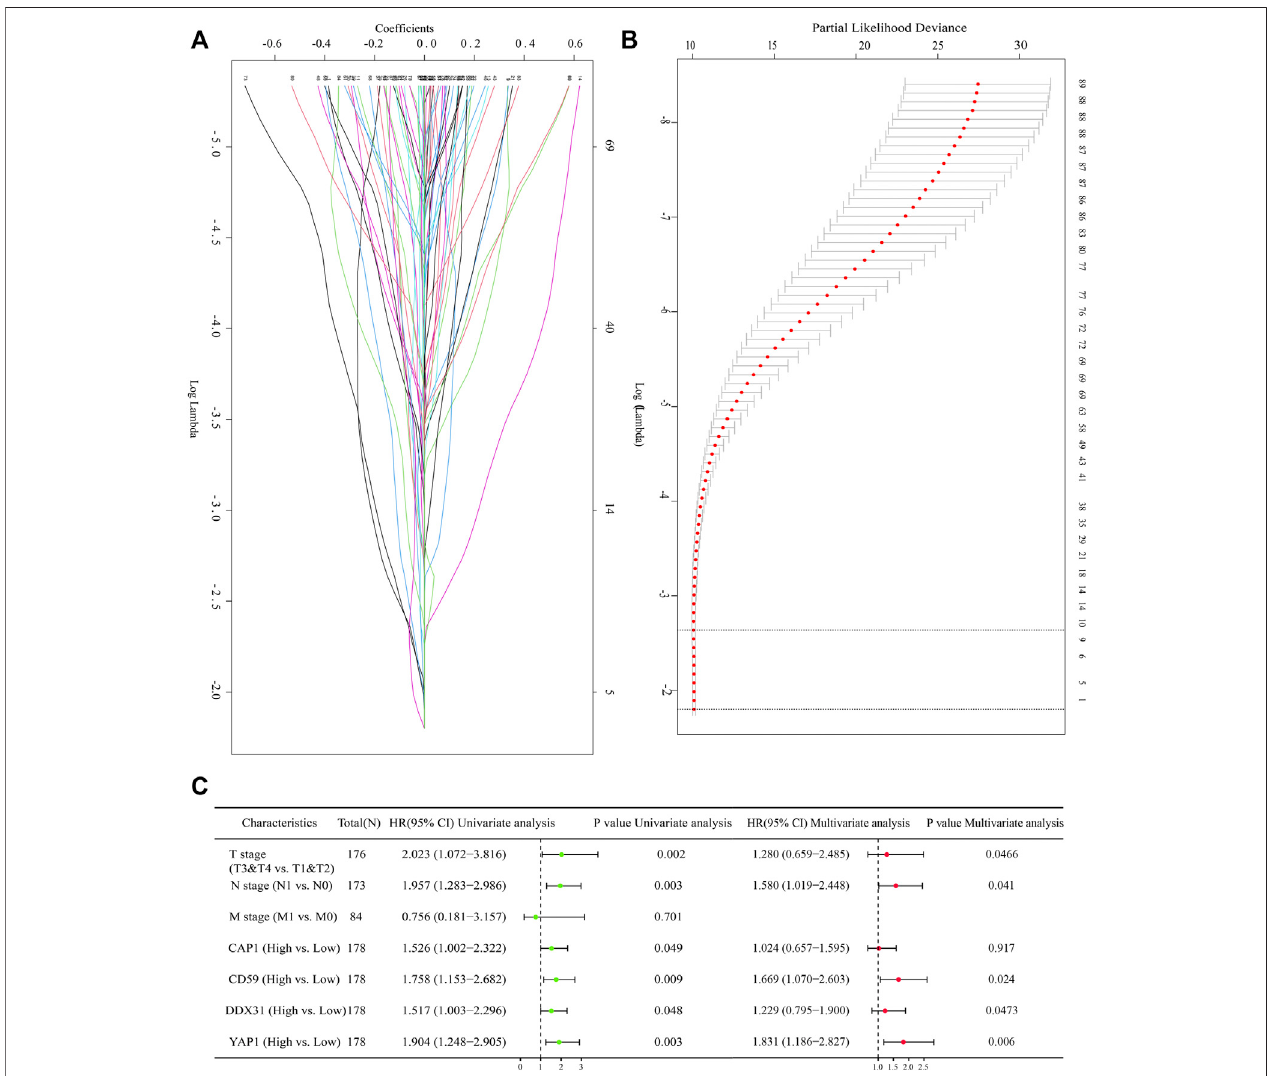
FIGURE 2 | Screening of prognostic genes with Lasso regression analysis. (A) : Lasso-Cox regression con fi rmed the regression coef fi cients of each gene. Lasso method can achieve the effect of variable selection, the insigni fi cant variable coef fi cient compressed to 0; With the increase of lambda, its absolute value is compressed accordingly,andsomerelativelyunimportantvariablesarecompressedto0.Theordinaterepresentstheregressioncoef fi cient,Thehorizontalcoordinaterepresentsthe log λ value; (B) :Identifyingthesuitableparameter( λ ).Fitcurveisacurvethatmatchesthelassoregressiontoshowtheappropriatelog λ value.Thelog λ valueofthe range ofthetwostraight linesinthemiddleperpendicular totheX axisistheoptimal log λ valuerange. (C) :Forestdiagramshowingtheselected variableswithunivariate and multivariate cox regression analysis. The selected variables contained DDX31 , CAP1 , CD59 , YAP1 ; The common clinical staging parameters such as T, N, M staging were included in multivariate Cox regression analysis. P value less than .05 is considered to be statistically signi fi cant, and HR > 1 has the signi fi cance of promoting risk; HR < 1 has the signi fi cance of inhibiting risk.